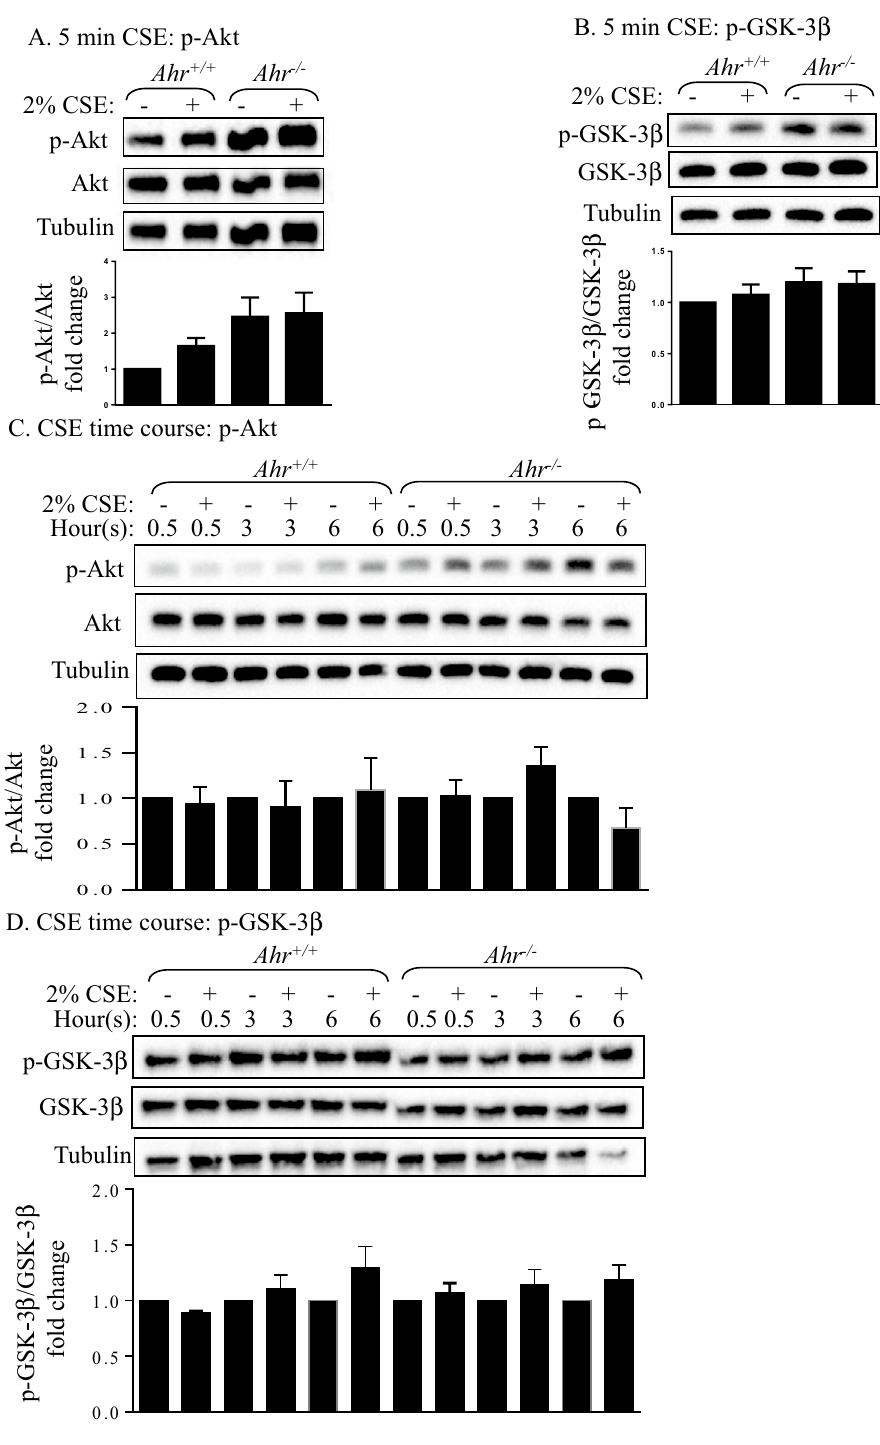
Figure 2. Effects of CSE on Akt and GSK-3β phosphorylation. ( A , B ) Serum-starved Ahr +/+ and Ahr −/− MLFs were treated with or without 2% CSE for 5 min and cellular protein was collected for western blot analysis of ( A ) Akt and ( B ) GSK-3β phosphorylation. ( C , D ) Ahr +/+ and Ahr −/− MLFs were treated with or without 2% CSE for 0.5, 3, and 6 h, and cellular protein was collected for Western blot analysis of ( C ) Akt and ( D ) GSK-3β phosphorylation. Blots are representative of ( A , B ) four or ( C , D ) three independent experiments. Densitometric values of the phosphorylated proteins were normalized to the values of their corresponding total proteins and are converted to fold changes relative to that of ( A , B ) the control Ahr +/+ cells or ( C , D ) untreated control groups at each time point. Results are expressed as mean ±